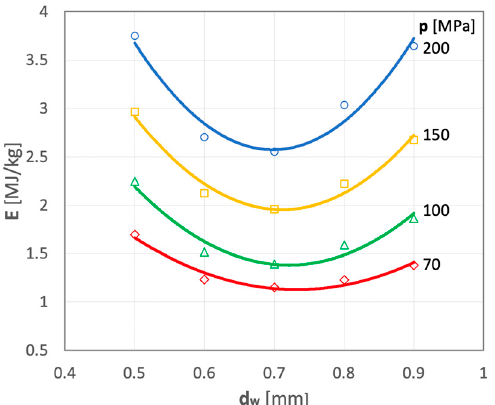
Figure 18. Specific energy expenditure (E) required to comminute polymetallic nodules as a function of water nozzle diameter (d w ) for selected water pressure levels (for: d h = 2.4 mm and s = 10 mm).